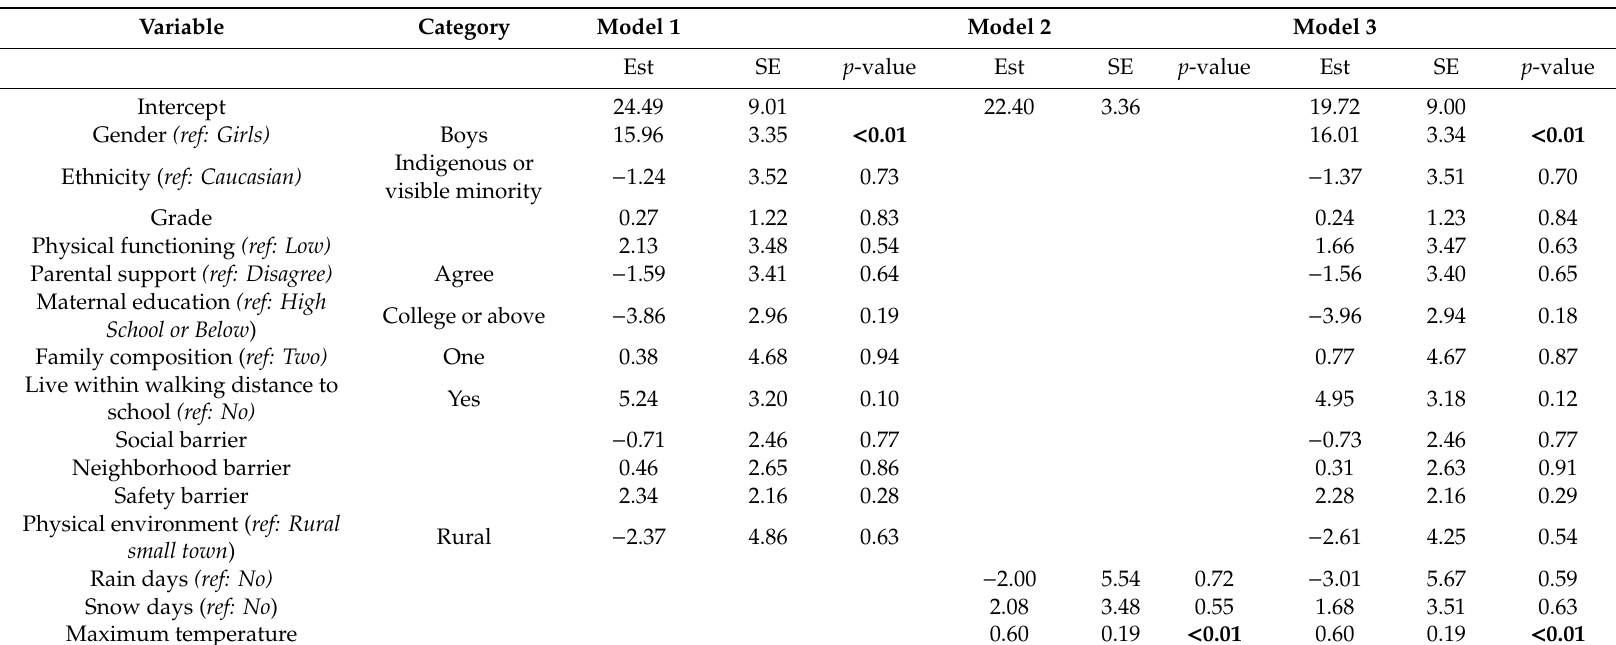
Table 4. The mixed model assessing the relationship between children’s out of school MVPA and child variables (Model 1), day variables (Model 2), and child- and day-level variables (Model